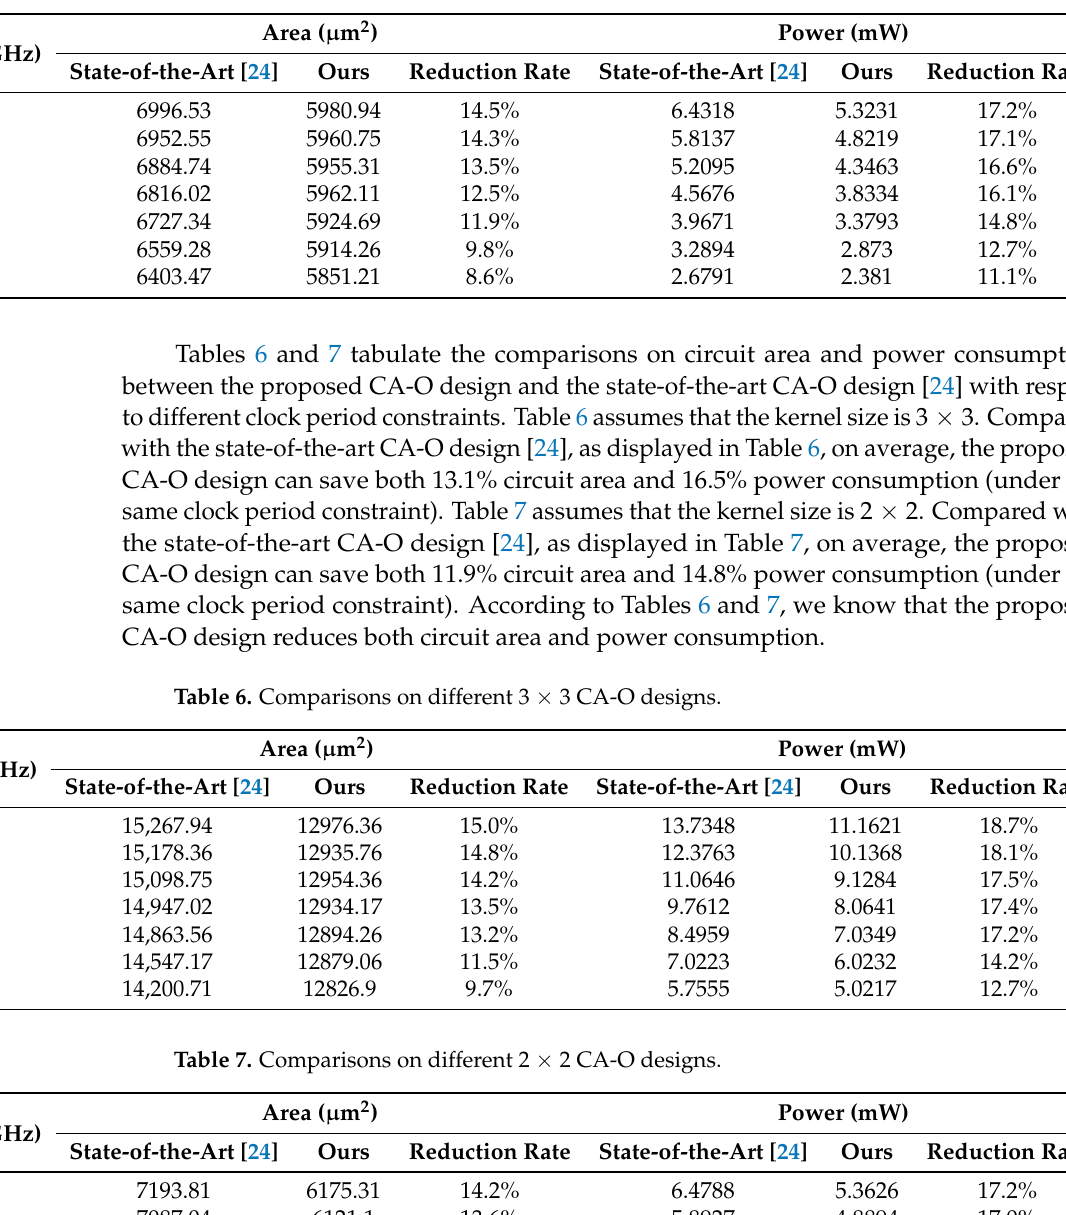
Table 5. Comparisons on different 2 × 2 CA-W designs.